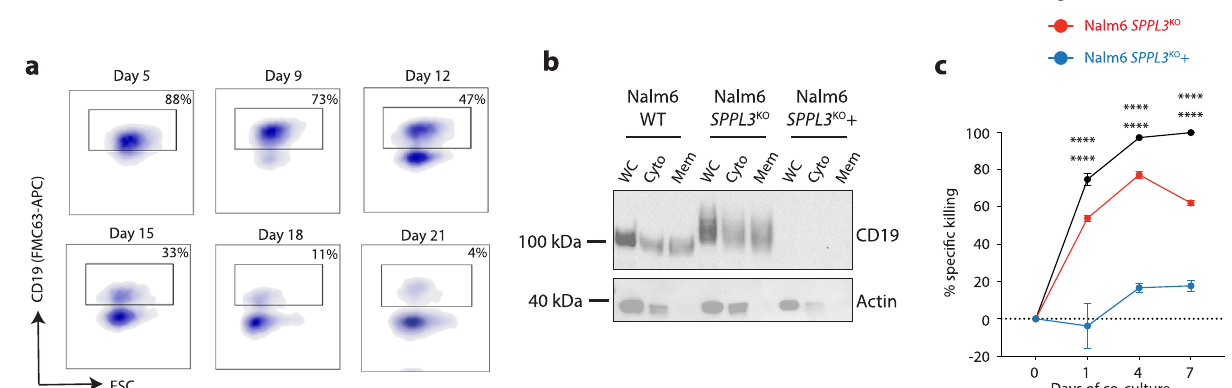
Fig. 5 Overexpression of SPPL3 results in loss of CD19 surface expression. a Sequential fl ow cytometric evaluation of FMC63-APC binding on SPPL3 KO + Nalm6 after overexpression of SPPL3. b Western blot of fractionated cellular lysates from WT, SPPL3 KO or SPPL3 KO with overexpression of SPPL3 ( SPPL3 KO + ) Nalm6 cells probed for CD19 performed 20 days after engineering. Representative of n = 2 individual experiments. c Survival of WT, SPPL3 KO , or SPPL3 KO + Nalm6 over time when established on 20 days after re-introduction of SPPL3 (E:T 0.25:1). Representative data from n = 2 experiments with independent T cell donors. Error bars re fl ect mean ± standard error of the mean (s.e.m.). **** P < 0.0001 by two-way ANOVA with Bonferroni correction for multiple comparisons. Statistical annotations re fl ect differences between WT and SPPL3 KO (upper) or WT and SPPL3 KO + Nalm6 (lower). Source Data are provided as a Source Data fi le.